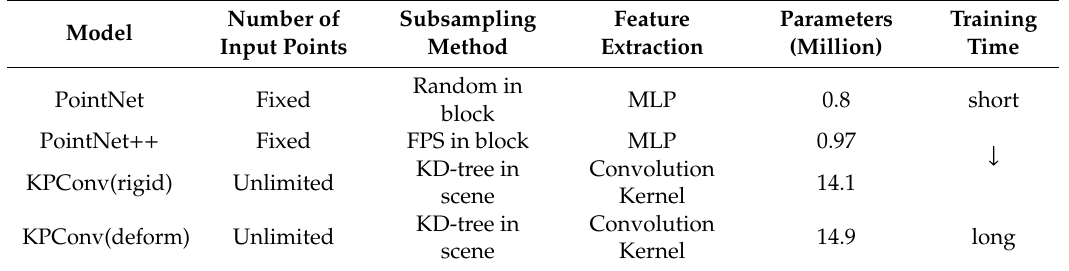
Table 1. Comparison of different architecture of 3D deep learning models.